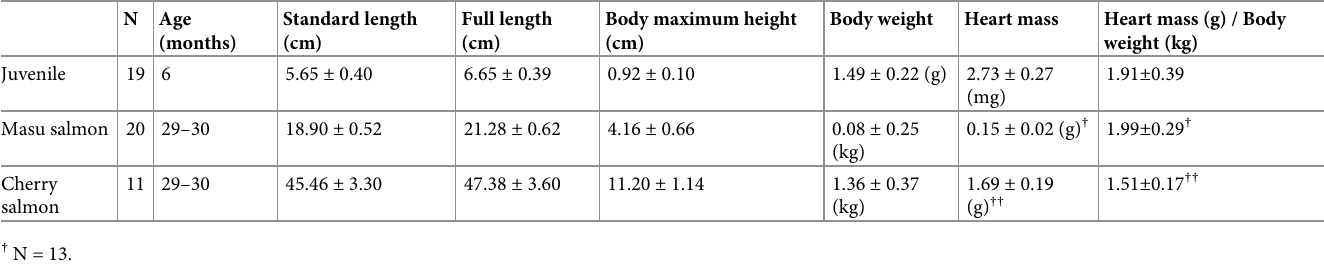
Table 1. Body size and heart mass measurements (means ± standard deviation) for Oncorhynchus masou masou . N Age (months)